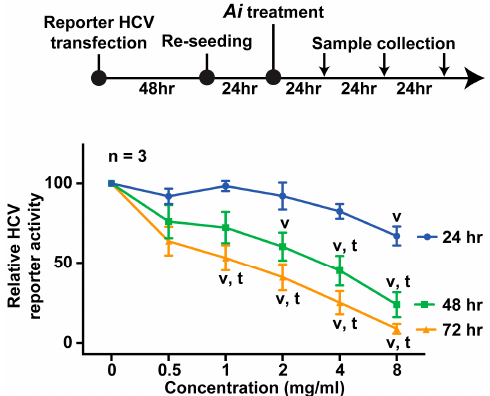
Figure 3. Effects of the Aeginetia indica decoction on the HCV reporter activity in Huh7.5.1 cells. Values are mean ± SEM summarized from three independent experiments and normalized against those under the vehicle control (0 mg/mL). Blue, green, and yellow lines represent respectively the HCV reporter activity measured at 24, 48, and 72 h after exposure to the idicated doses. Ai, Aeginetia indica decoction; v , p < 0.05 t -test against values under the vehicle control; t , p < 0.05 t -test against values at 24 h.